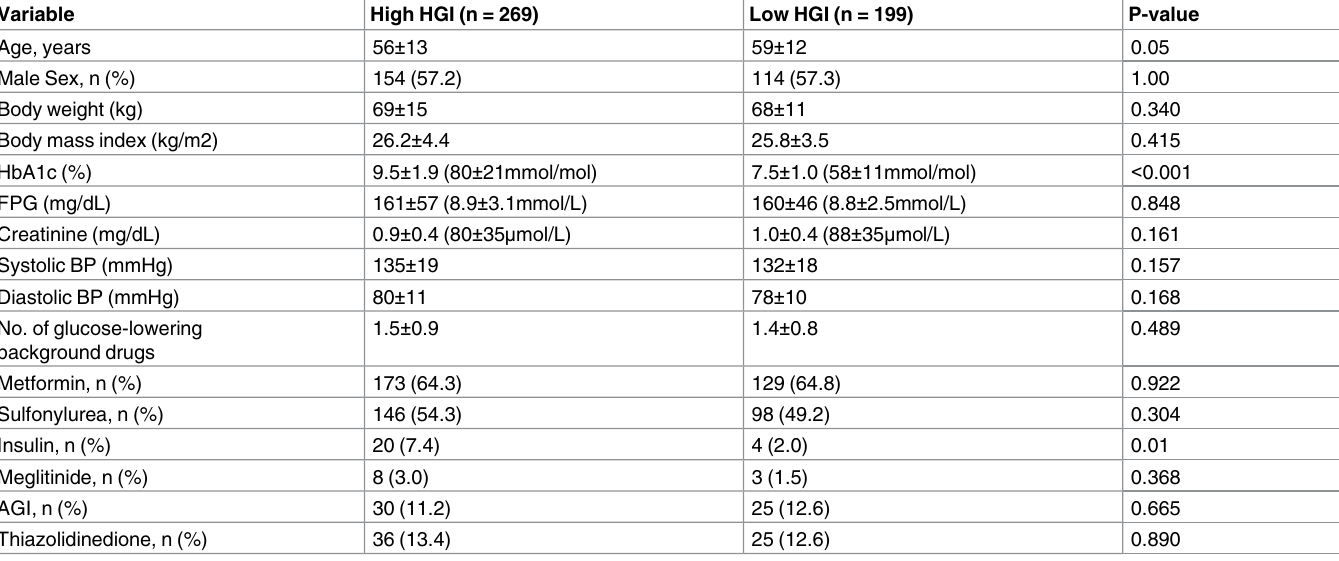
Table 1. Demographic and baseline characteristics of the study